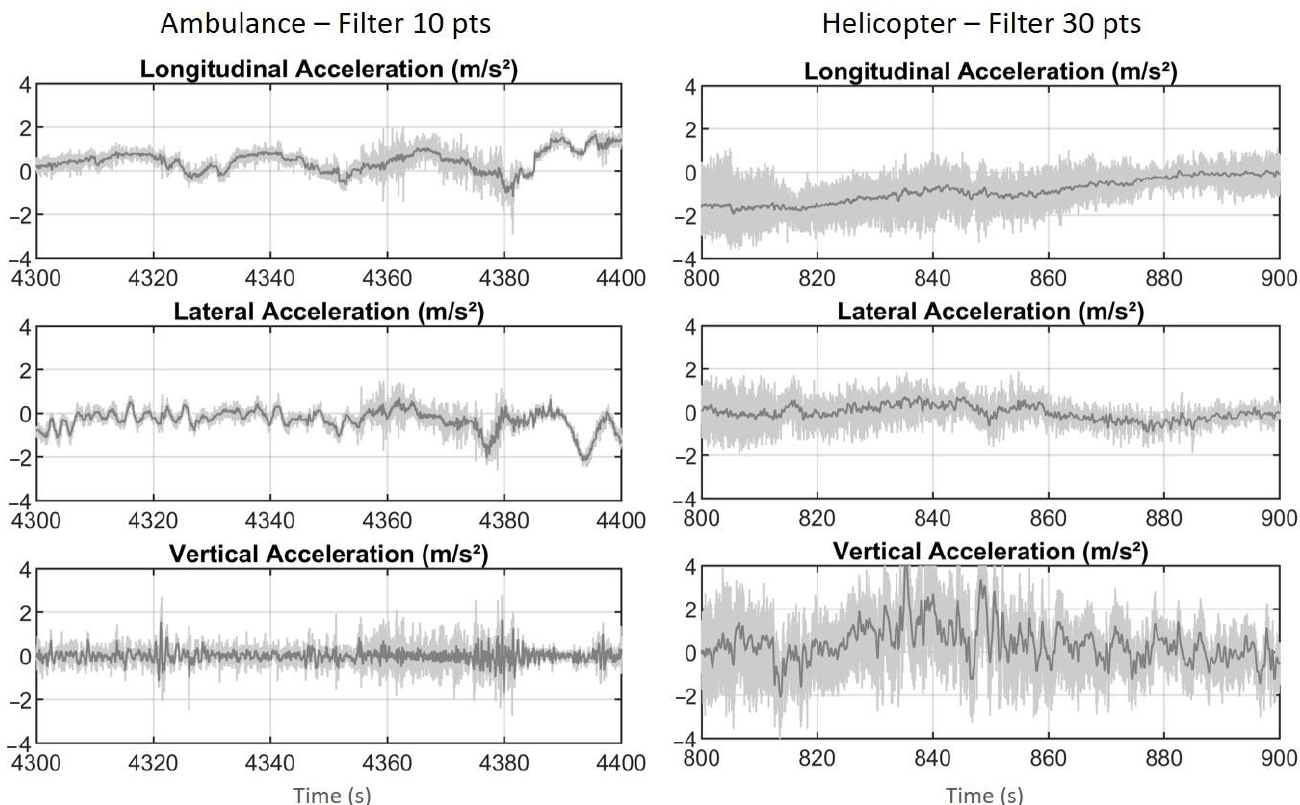
Figure 4. Acceleration filtering in ambulance and helicopter — examples over 100 s periods .